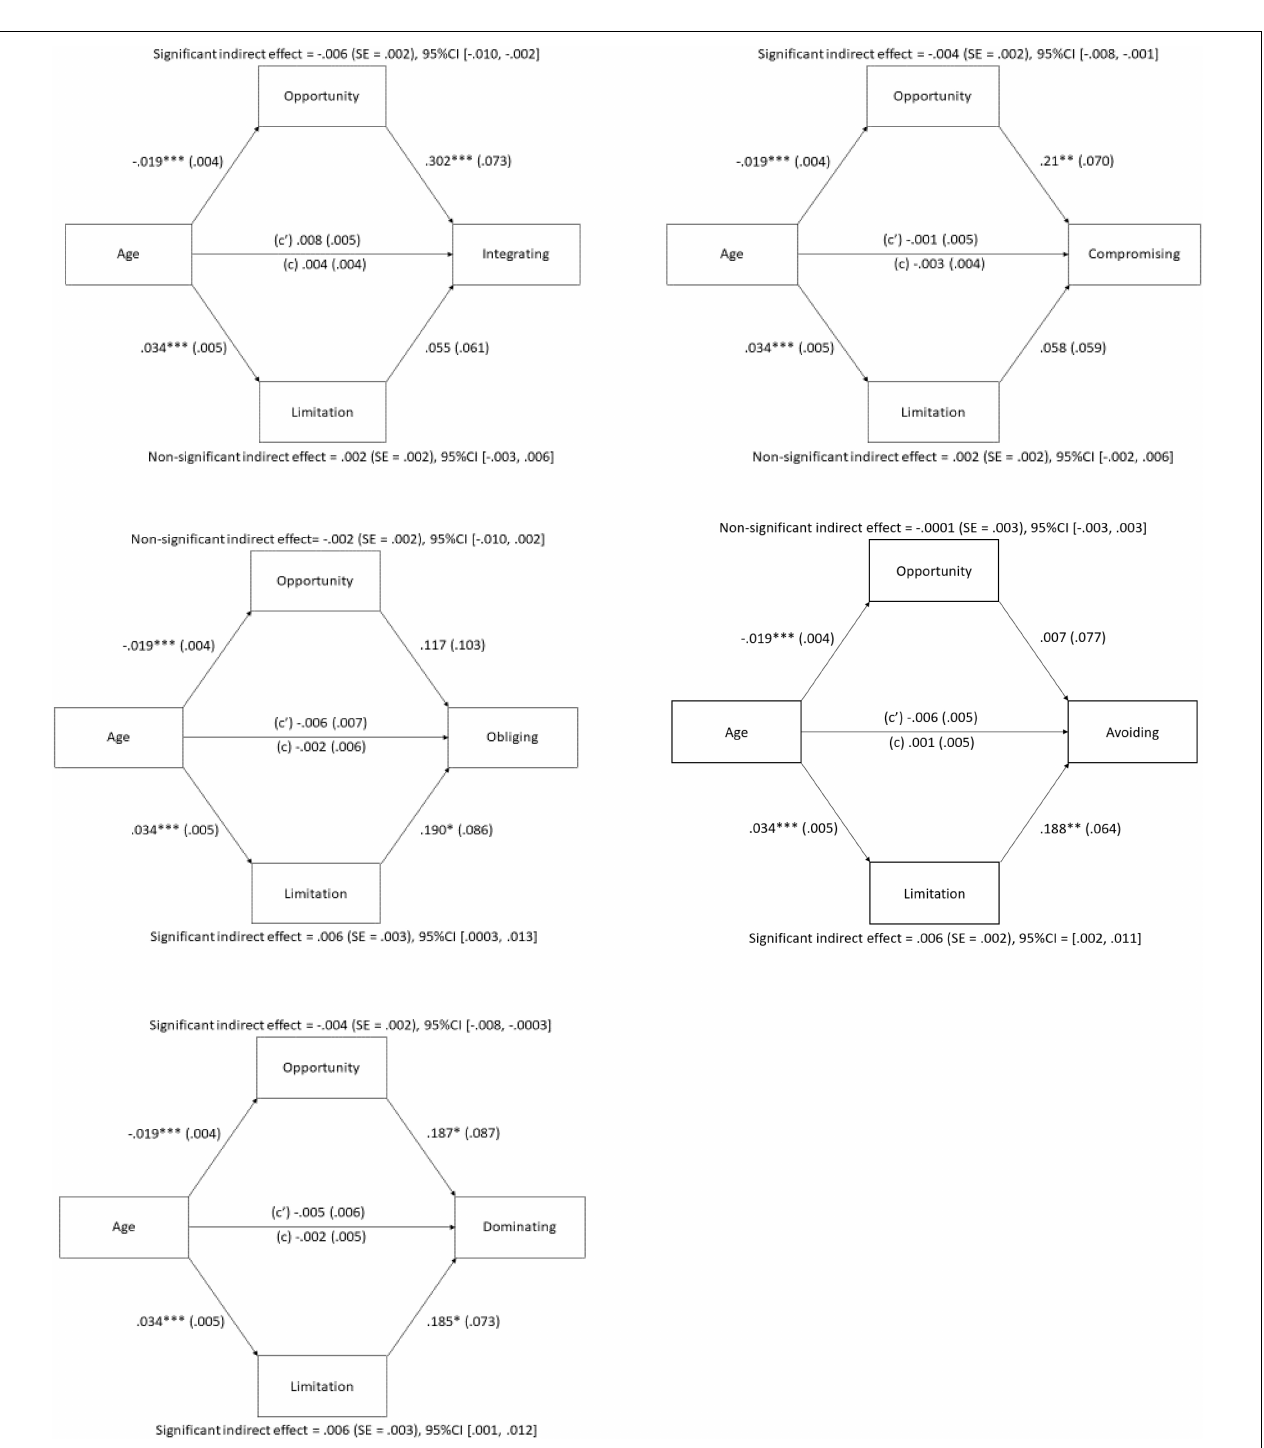
FIGURE 2 | The mediating effects of focus on opportunities and focus on limitations on the five conflict management strategies measured in Study 2. c’ = direct effect. c = total effect. Opportunity = Focus on opportunities. Limitation = Focus on limitations. ∗ p < 0.05; ∗∗ p < 0.01; ∗∗∗ p < 0.001.